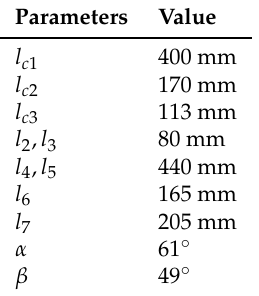
Table 1. Parameters of the